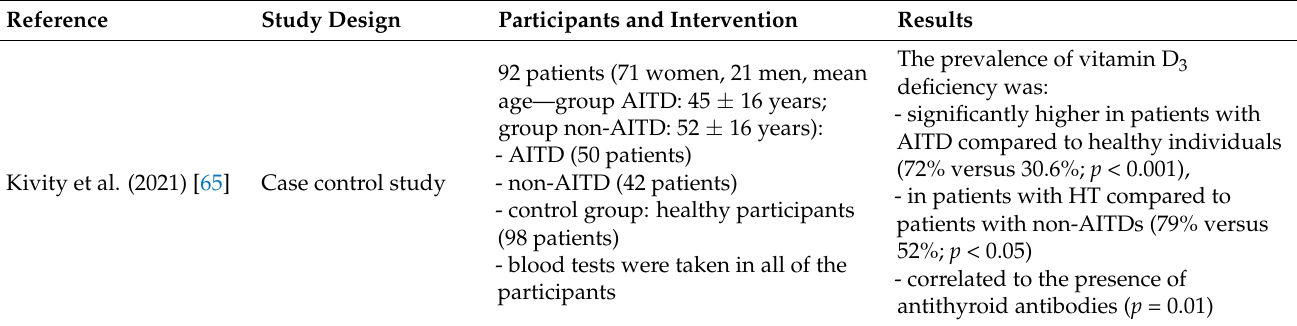
Table 1. The relationship between vitamin D 3 and AITD on the basis of the literature